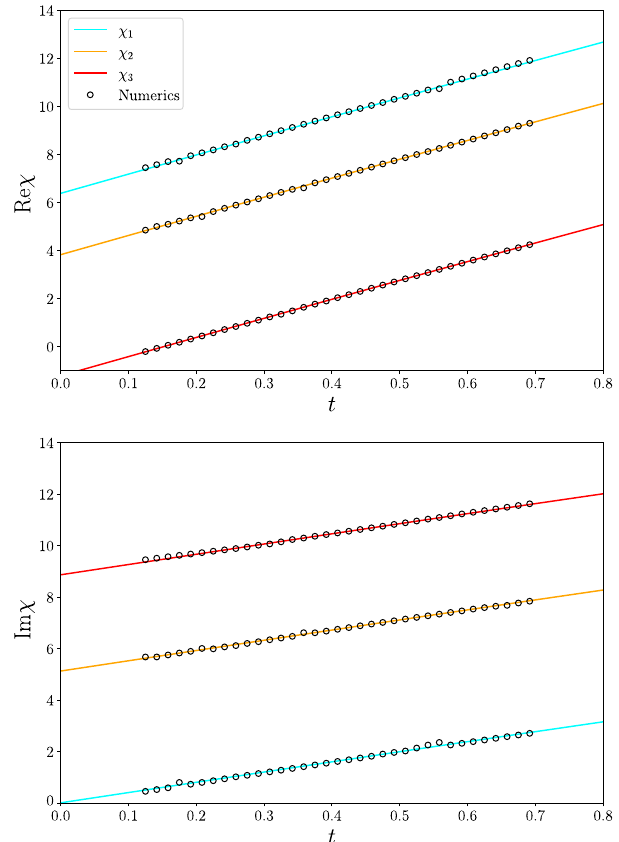
FIG. 4. Comparison between the time evolution of the three singulants of smallest norm as determined numerically (open circles) and the prediction Eq. (30) (solid lines). The matching has been performed at t ¼ 0 . 5 . The color coding of the lines coincides with the color coding of the stars in the bottom panel of Fig. 3. Upper panel: real parts. Lower panel: imaginary